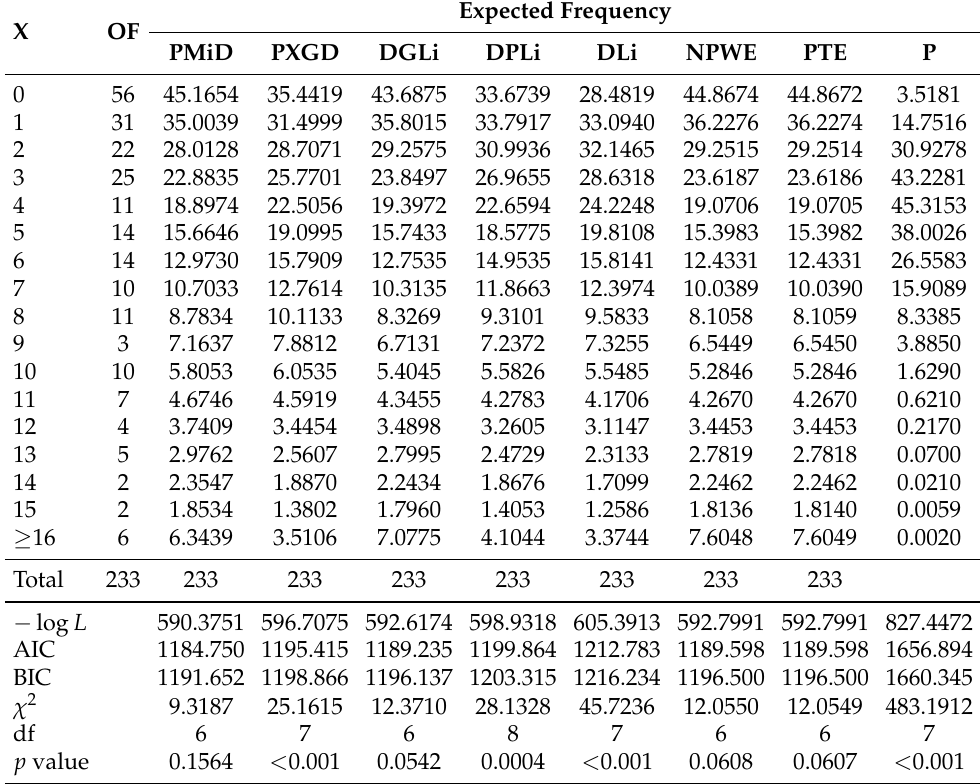
Table 6. Armenia dataset: Goodness-of-fit